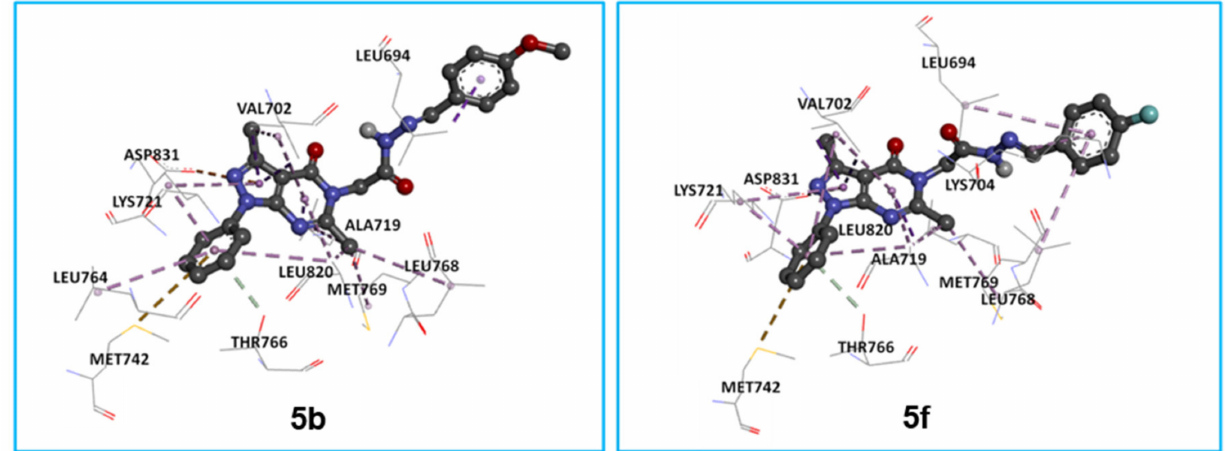
Figure 7. Binding modes of conjugates 5b and 5f in the erlotinib binding site of the EGFR (PDB: